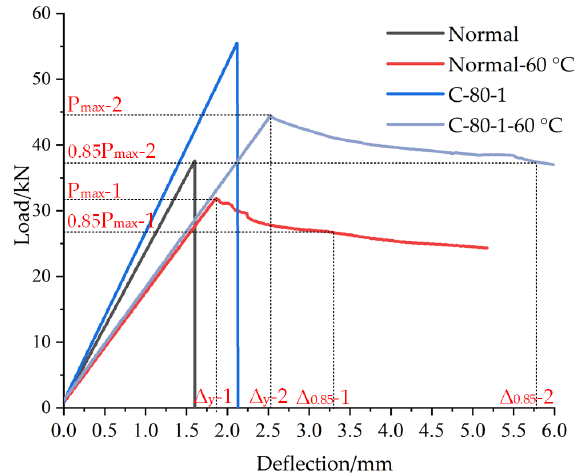
Figure 18. Load–deflection curves of specimens.